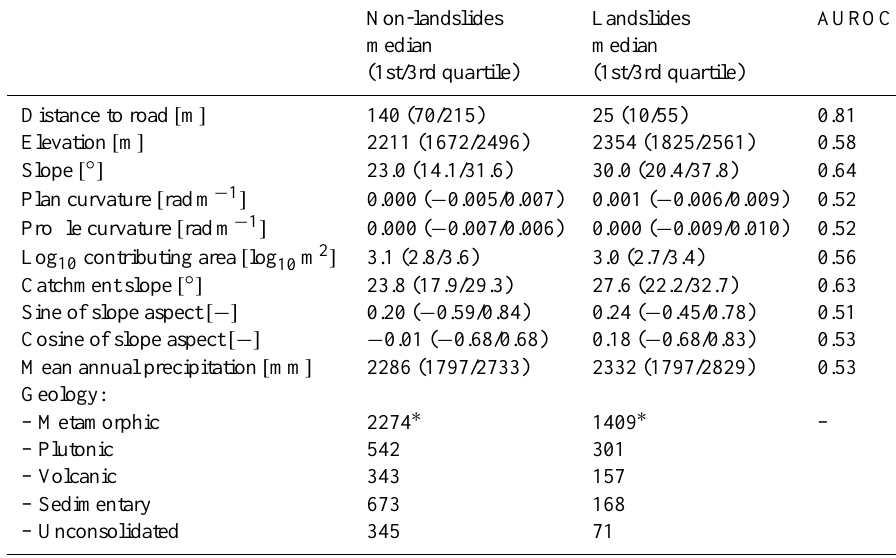
Table 1. Descriptive statistics of the data set used for statistical modeling.